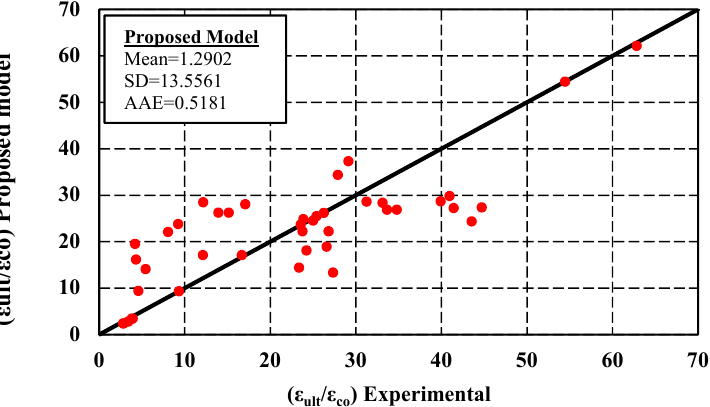
(cid:3084) (cid:3296)(cid:3287)(cid:3295) Figure 15. Comparison of ε ult Figure 15. Comparison of values obtained from the proposed model (Equation (19c)) and ex- ε co values obtained from the proposed model (Equation (19c)) and (cid:3084) (cid:3278)(cid:3290) experimental perimental data.